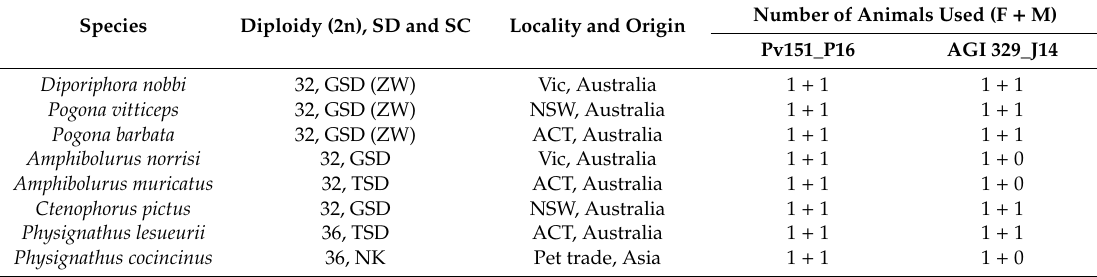
Table 1. Table showing list of species, chromosome numbers, location of origin, modes of sex determination and numbers of individuals used in this